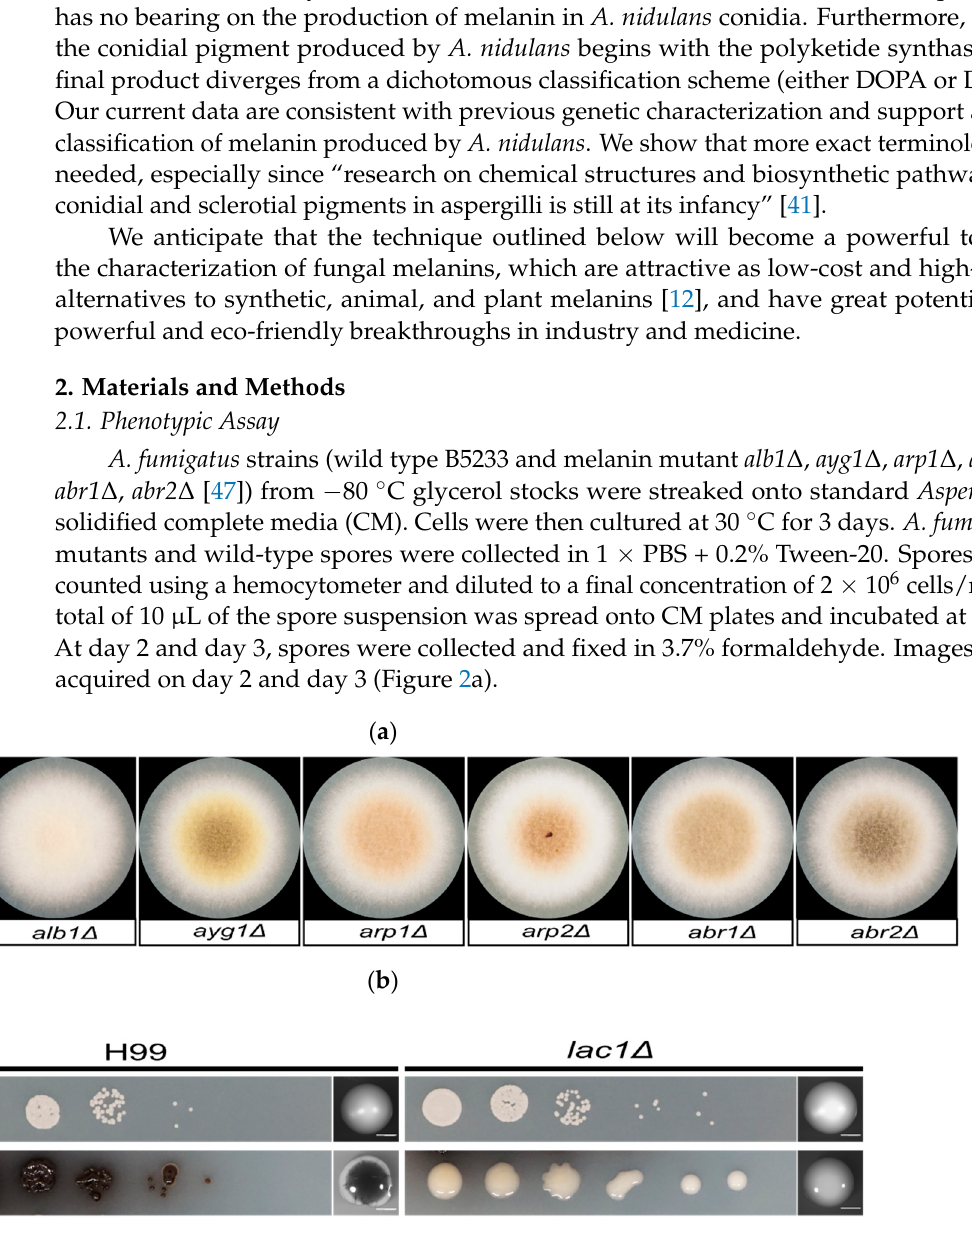
Figure 2. ( a ) Individual colony of the melanin mutant and the A. fumigatus wild-type control (B5233). A total of 10 µ L of a 2 × 10 6 cells/mL cell suspension for each strain was inoculated onto the center of an Aspergillus complete media (CM) plate. The plates were incubated at 30 ◦ C for 3 days. ( b ) The laccase mutant ( lac1 ∆ ) and the C. neoformans wild-type control (H99). In total, 3 μ L of the serial dilutions were dropped onto YNB medium and L-Dopa media. Scale bar: 2000 μ m.